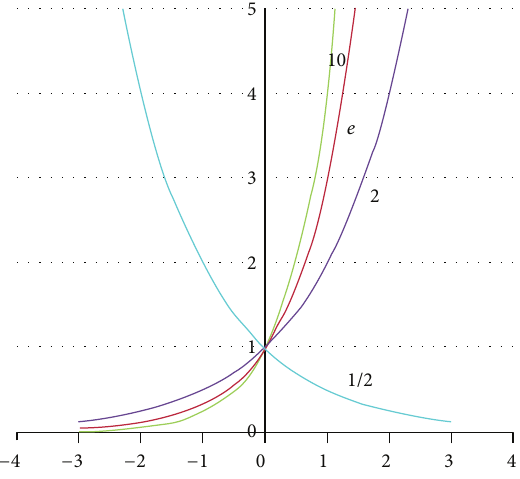
Figure 3: Variation in the value of base 𝑎 𝑛 parameter.